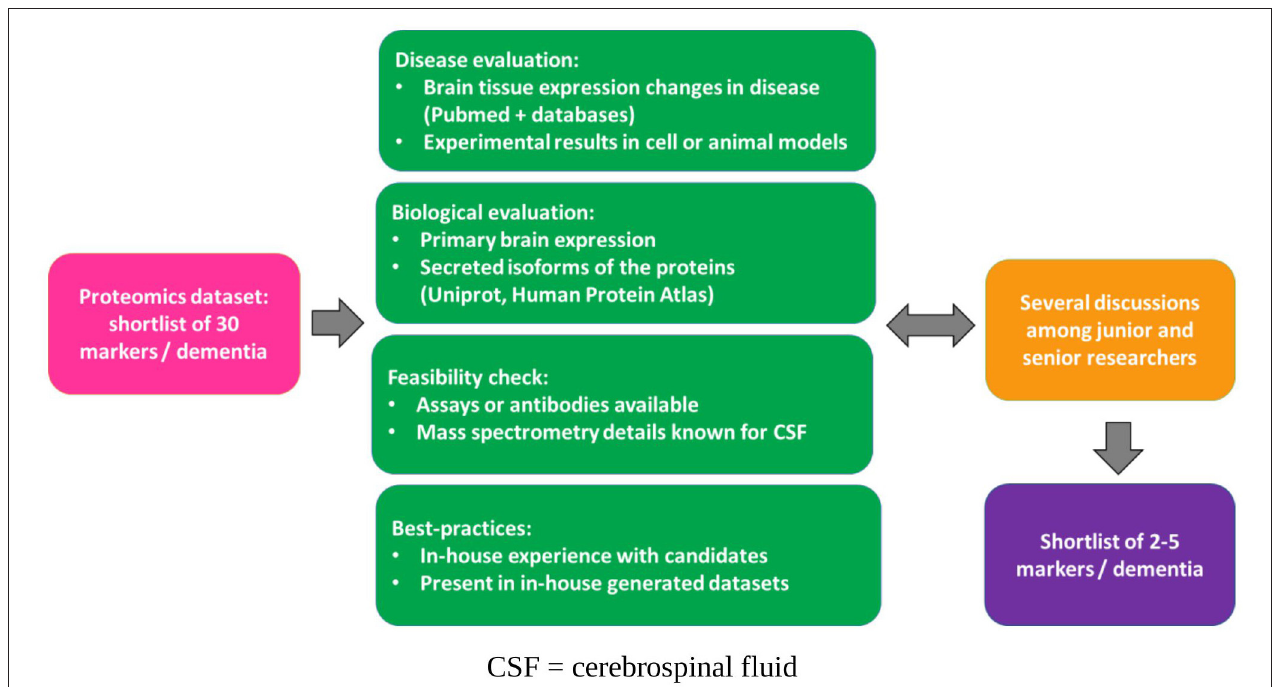
FIGURE 2 | Schematic representation of the steps taken for biomarker selection in MIRIADE. CSF, cerebrospinal fluid.